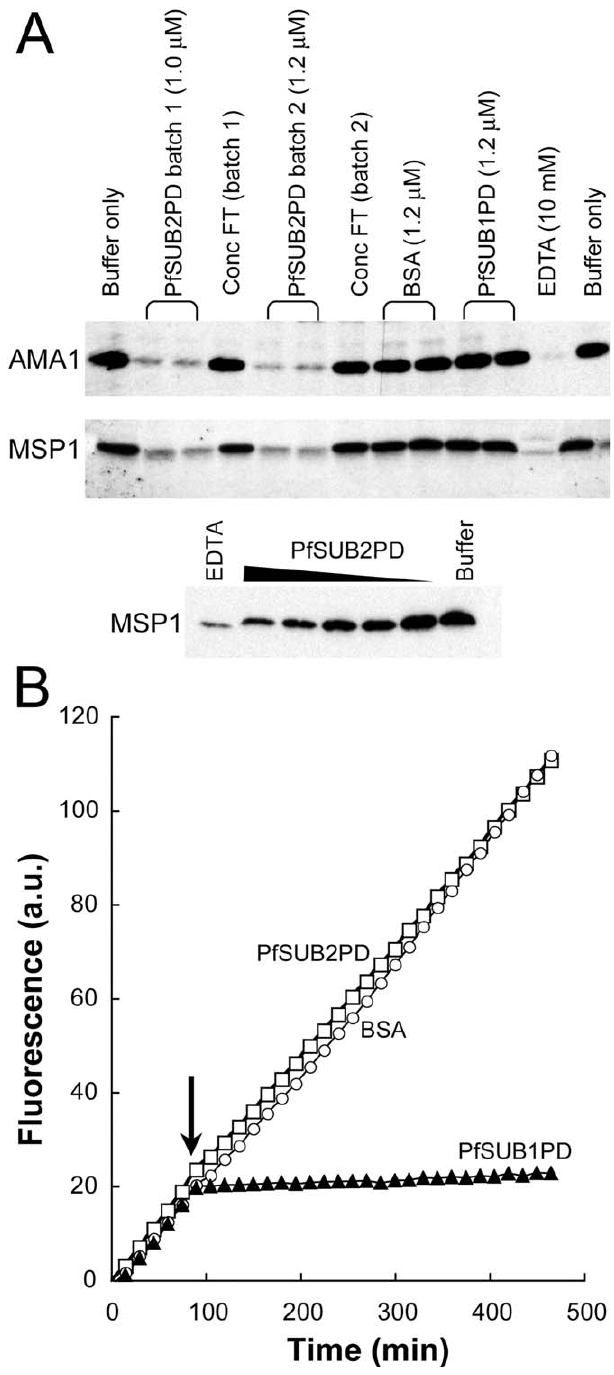
Figure 6. PfSUB2PD Inhibits MESH in a Selective, Dose-Dependent Manner (A) Shedding of AMA1 and MSP1 from isolated merozoites was assayed in the presence of the indicated additives. Two different batches (1 and 2) of purified PfSUB2PD were tested, in each case alongside a similar dilution of the membrane flow-through (Conc FT) from the final step of concentration by ultrafiltration. Control additives used were bovine serum albumin (BSA), purified PfSUB1PD, and EDTA. No effect on processing was seen if PfSUB2PD was added to buffer control reactions at the end of the incubation period (extreme right-hand lane). The lower panel shows a titration of inhibition of MSP1 shedding in the presence of 2-fold serially decreasing concentrations of PfSUB2PD (from 1.2 l M to 0.075 l M). (B) Effect of propeptides on PfSUB1 activity. Progress curves